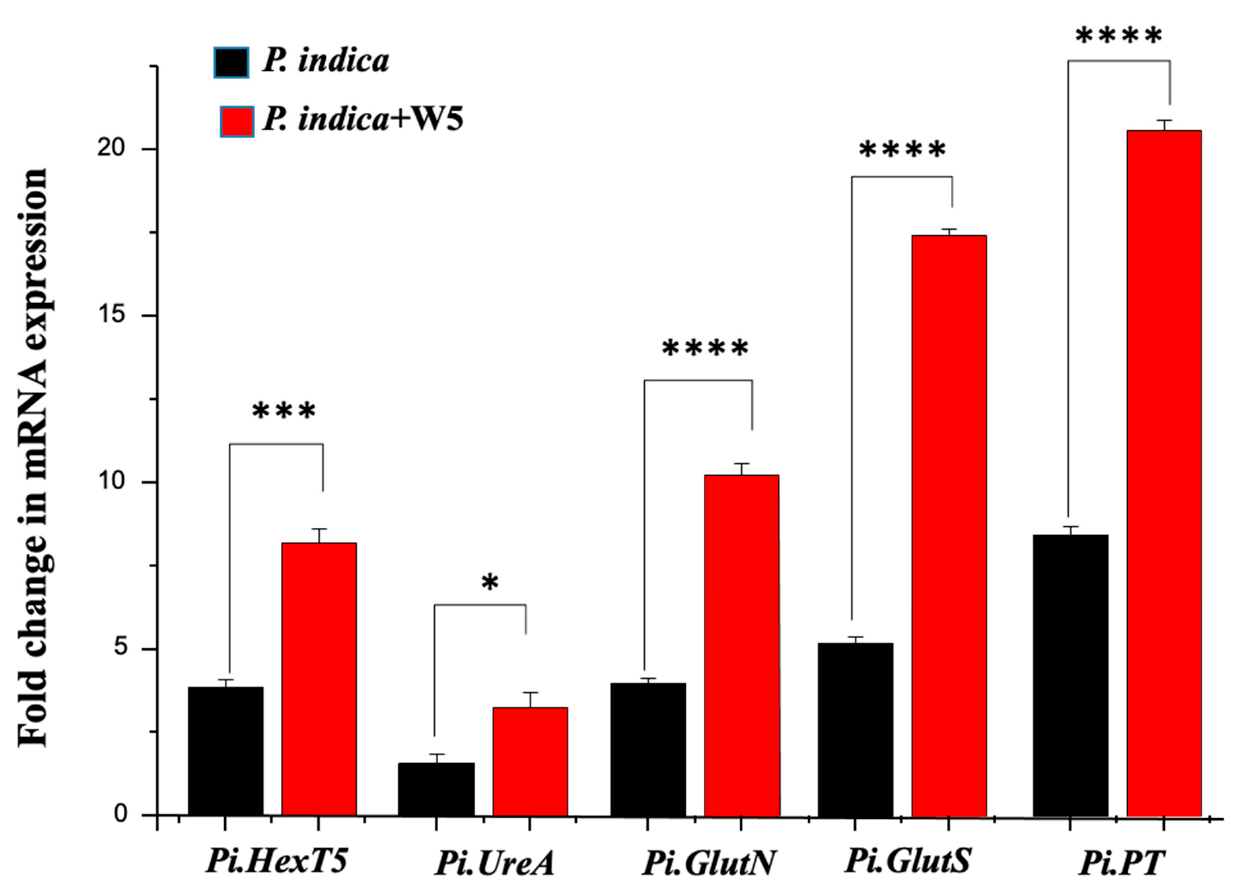
Figure 4. Relative fold changes of the P. indica genes Pi.HexT , Pi.UreA , Pi.Glut.N , Pi.Glut.S , and PiPT observed in-vivo within O. sativa roots 96 HPI with P. indica either in the presence or absence of W5. Values signifies the mean of replicates ( n = 3, p -value * ≤ 0.05, *** ≤ 0.001 and **** p ≤ 0.0001) compared with P. indica . Standard error (SE) is represented by error bars.